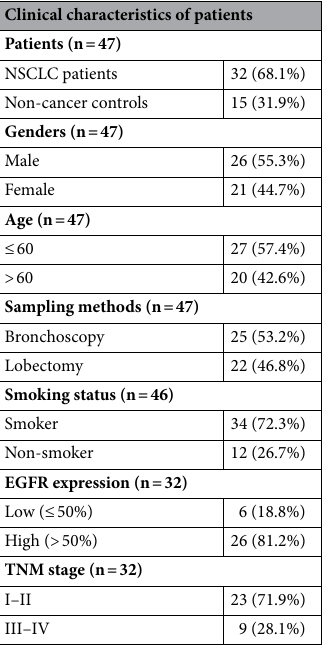
Table 1. Clinical characteristics of